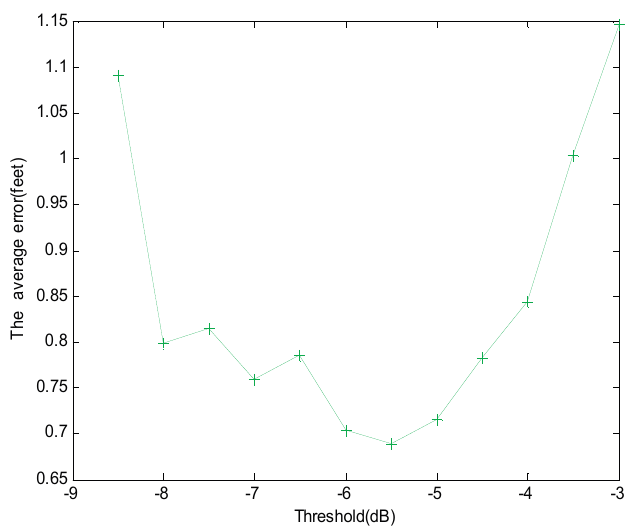
Figure 6. The errors when γ changes.